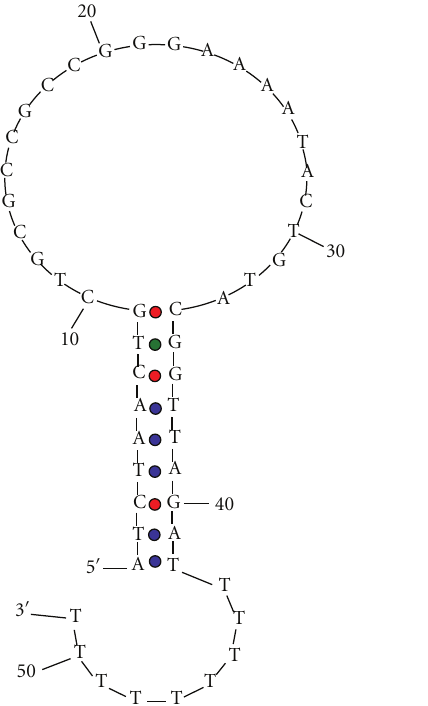
F 2: Predicted folded structure of sgc-8 aptamer generated by mfold [17].